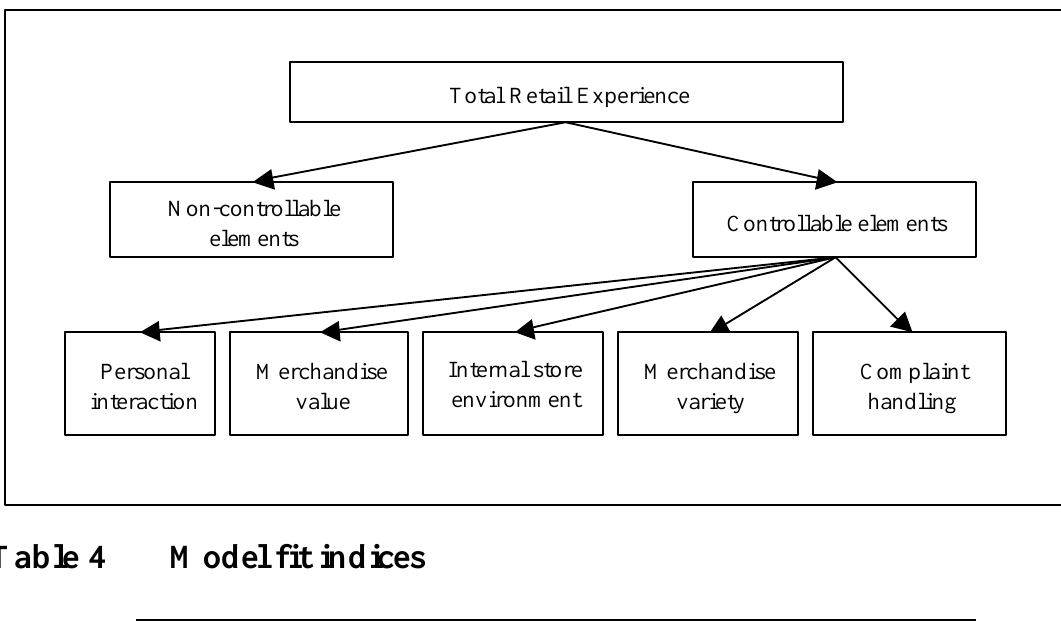
Empirical results of Survey 2: Clothing